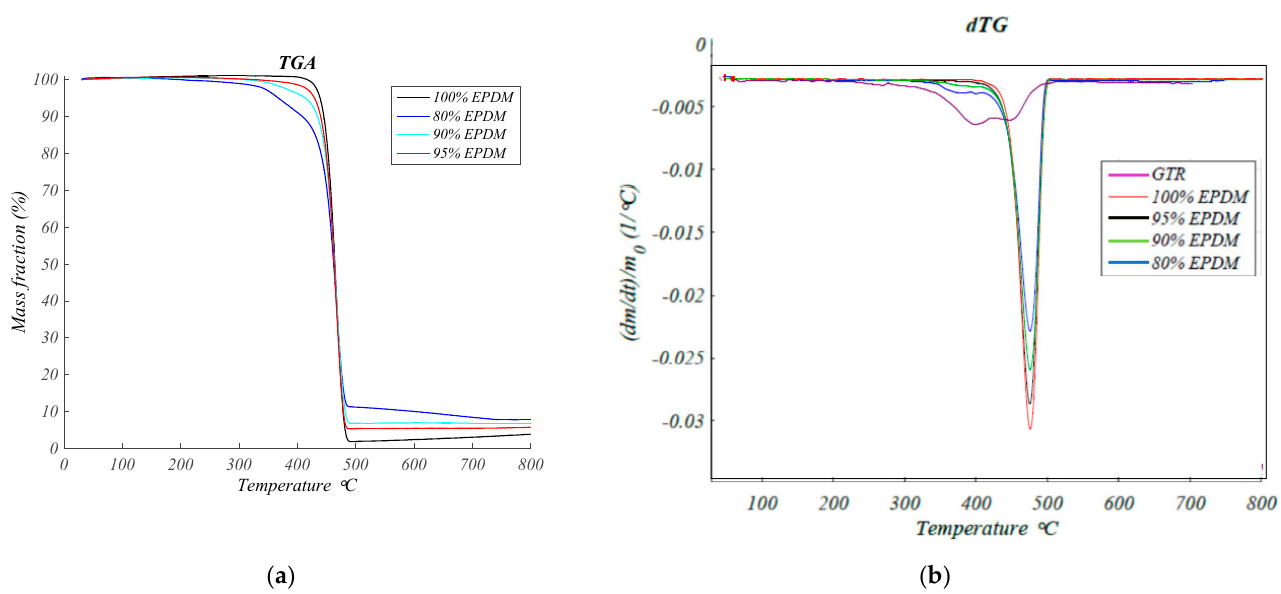
Figure 2. Thermogravimetric analysis: ( a ) Mass fraction (%) versus Temperature ( ◦ C), for EPDM and EPDM/GTR samples; ( b ) Rate of weight loss versus Temperature ( ◦ C), for EPDM and EPDM/GTR samples.